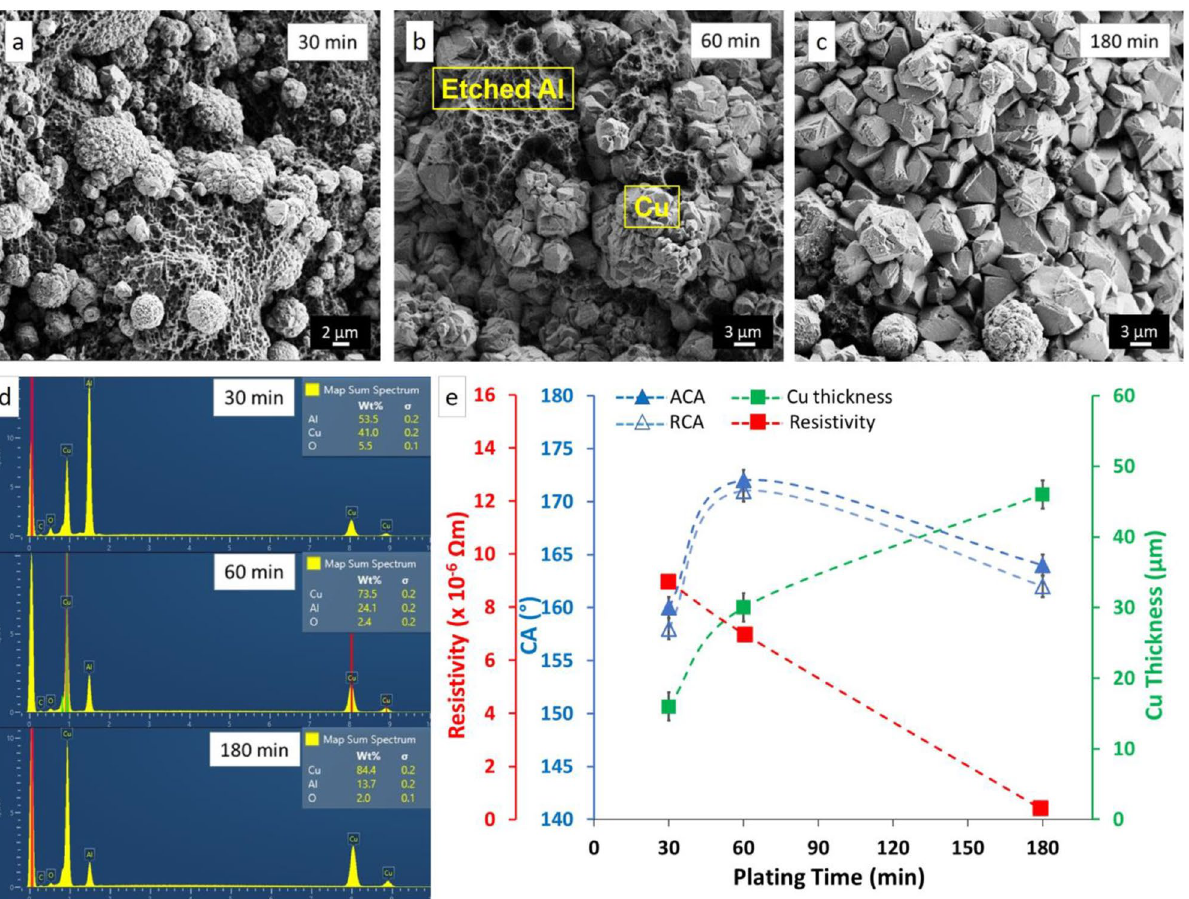
Figure 2. Morphologies of Cu on etched Al after ( a ) 30 min, ( b ) 60 min, and ( c ) 180 min of electroless plating. The morphology of the plated Cu changed from micro-particles to a continuous film with increasing plating time. ( d ) EDX analysis of Al/Cu samples after 30 min, 60 min, and 180 min of Cu electroless plating. Even after 180 min of Cu plating, some Al is detectable, indicating that the copper film coverage is not full 100%. ( e ) The effect of copper plating time on CAs, copper thickness, and resistivity of the resulting PDMS/Cu Copper electroless plating. Copper electroless plating was done on etched Al samples. Figure 1d shows the effect of the pre-etching step on the contact angle and plated copper thickness after 1 h of plating at room temperature. The contact angles were measured after a complete process that involved aluminum etching, Cu plating, PDMS curing, and sacrificial etching of aluminum. Copper plating on 2-step etched Al resulted in 30 ± 2 μm thick film after 1 h, whereas the thickness was 20 ± 2 μm for the one-step etched sample. The thicker copper film shows more pronounced nanoscale surface features and resulted in improvement of the CA values, as can be seen in Fig. 1e,f. Therefore, we chose to utilize the phosphoric-nitric acid pre-etching in all following experiments. To investigate the effect of Cu plating time on the morphology, CA values, and conductivity of PDMS/Cu material, samples were prepared with different plating times: 30, 60, and 180 min (Fig. 2a–c). The morphology of the plated copper changed from micro-particles to a continuous film and the thickness of plated copper increased from 16 to 46 μm as plating time increased from 30 to 180 min. After 30 min of plating, copper micro-particles are clearly distinguishable on the etched aluminum surface (Fig. 2a). After 60 min of plating, although copper